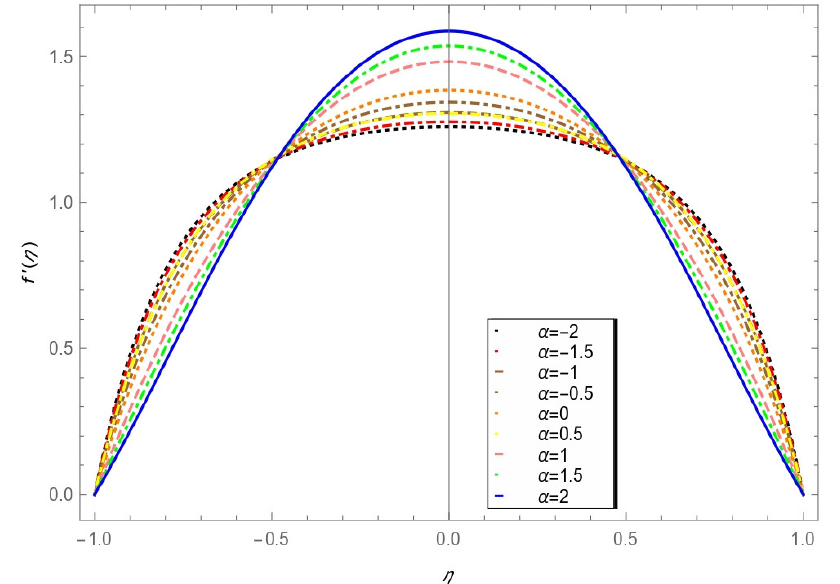
Figure 9. Radial velocity profile effect of the expansion ratio for Re = 1, ϕ 1 = ϕ 2 = 0.02, dp 1 = dp 2 = 20, M = 4, Fr = 0.1.